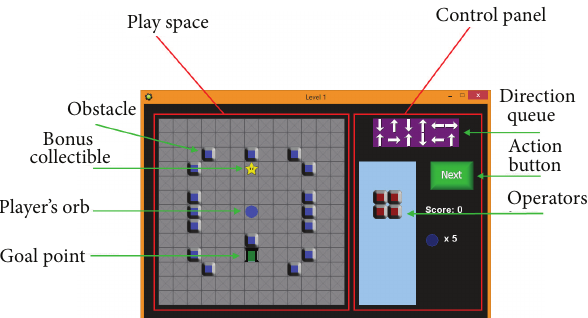
Figure 3: Screenshot of Game F with its UI components labeled.